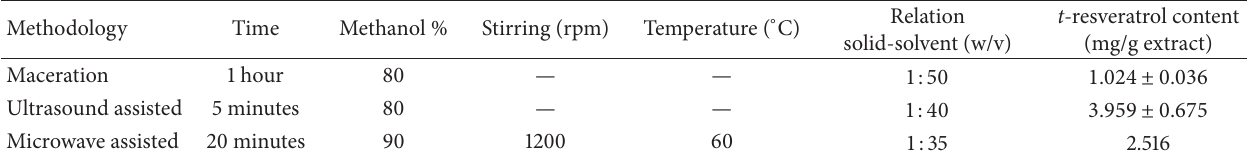
Table 4: Trans -resveratrol contents (mg/g extract) obtained in the present study by different extractive methodologies in optimized